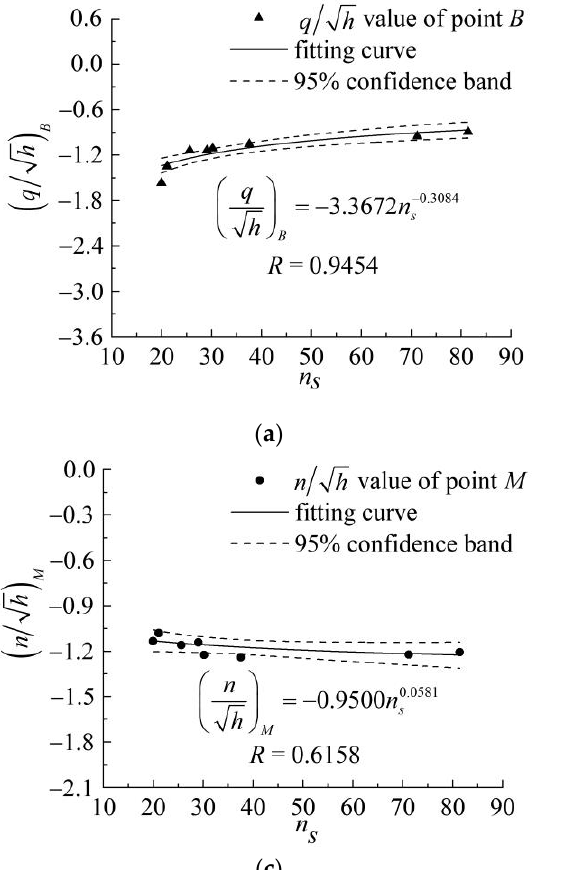
√ (cid:16) (cid:17) − 𝑛 𝑠 ; ( b ) − n s ; q / h 𝐵 B